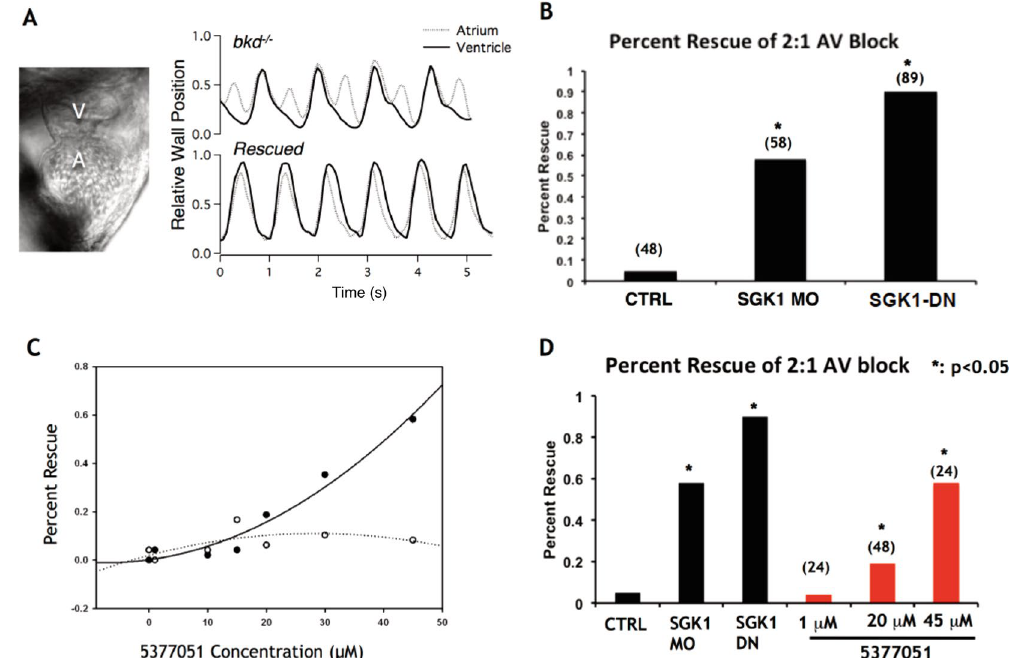
Figure 8. SGK1 inhibition rescues a zebrafish model of long QT. ( A ) Still frame image of zebrafish heart with chamber labels (A = atrium) (V = ventricle). Representative tracings of chamber wall position demonstrating 2:1 AV block in mutant bkd − / − zebrafish (upper panel) and with rescue of the phenotype (lower panel). ( B ) Knock-down with SGK1 morpholino or inhibition of SGK1 (500 μ M SGK1-DN mRNA) in the breakdance zebrafish mutants with long QT at 1–2 cell stage leads to significant rescue of 2:1 AV block at 99 hpf stage (5% spontaneous reversion at this stage); * p-value < 0.05 by Z-test. ( C ) Compound 5377051 added at 48 hours post fertilization (hpf) and assessed at 72 hpf for rescue of phenotype 2 with superimposed rescue (solid line) and toxicity (dashed lines) curves shown on left ( C ) and representative bar graph on right ( D ). * p < 0.05 by